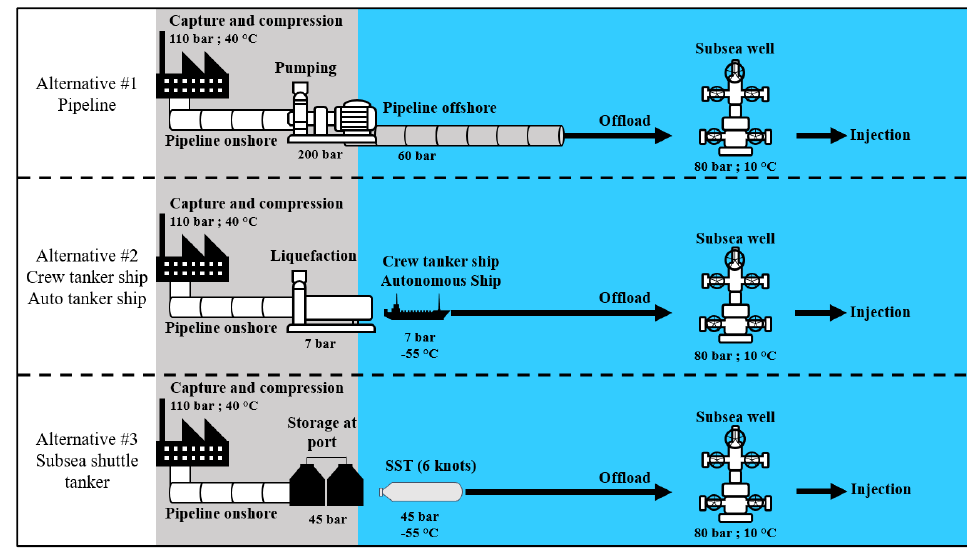
Figure 3. Offshore transportation methods for CCS.